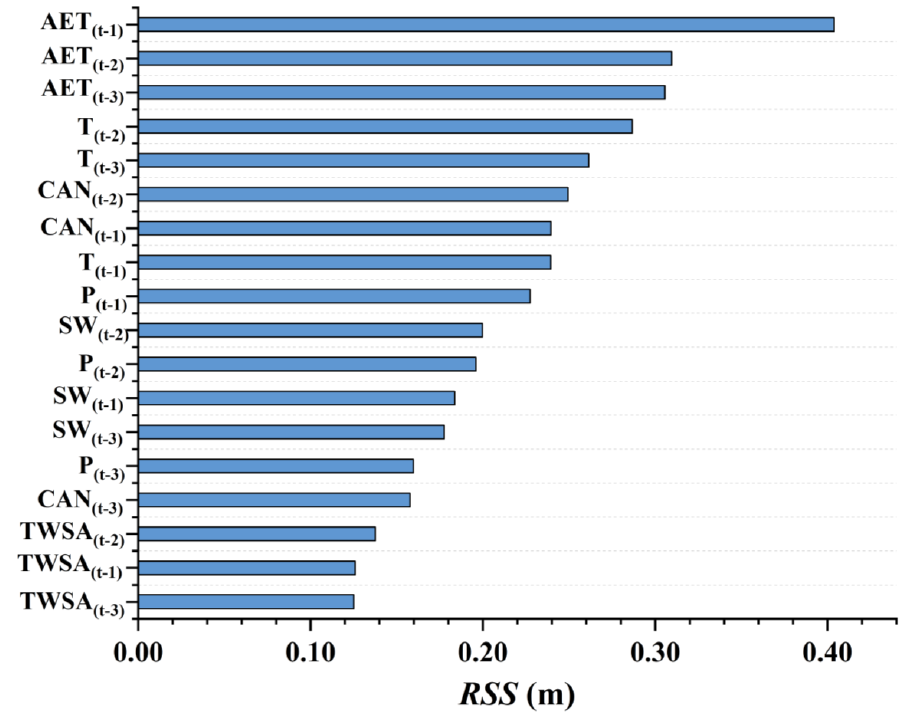
Figure 7. The averaged importance of the input variables. A higher value of the residual sum of squares (RSS) corresponds to a higher importance. When emphasizing the validity of the inputs, a comparison with similar studies is essential. For example, in the study by Zhang et al. [79], only groundwater recharge and actual evapotranspiration data were applied in GWL prediction. Compared with the R 2 values in this study ( R 2 > 0.67), both the back propagation and radial basis function models in their study yielded much a lower R 2 (<0.65). This indicated the great potential of the application of the satellite data and the land-surface model data in GWL prediction. At arid or semi-arid areas is limited, but they have been used in GWL prediction in coastal areas. For example, Yin et al. [65] used the GRACE and the Tropical Rainfall Measuring Mission (TRMM) satellite data in GWL prediction in Victoria, Australia; the average R values of the RF, ANN, and LSTM were 0.905, 0.973, and 0.788, respectively. Kalu et al.